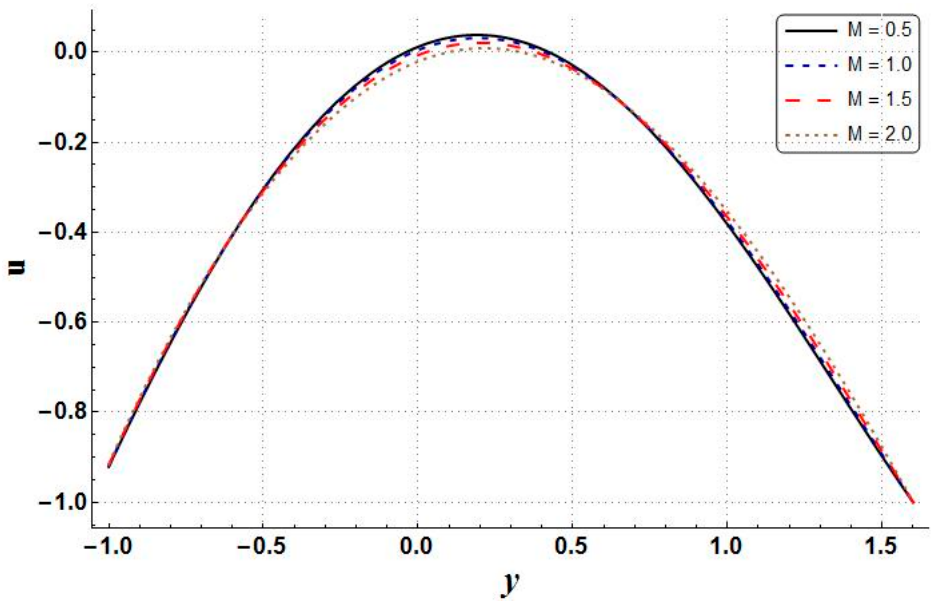
Figure 10. Influence on u through changing values of M , where γ = π φ = 0.05, k = 2, a = 0.6, m = 1, d = 0.7, Br = 0.2, b = 0.5, ∈ = 2, η = 0.8.